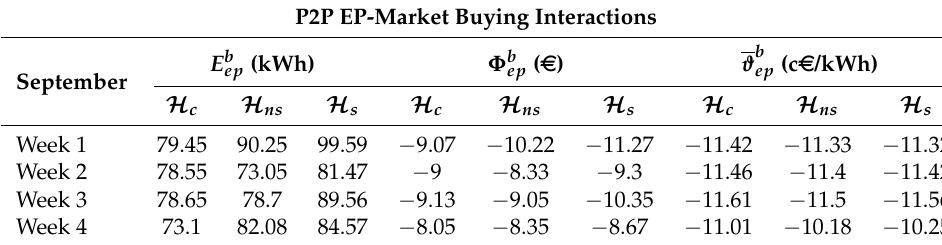
Table 5. P2P energy-package market buying interactions.